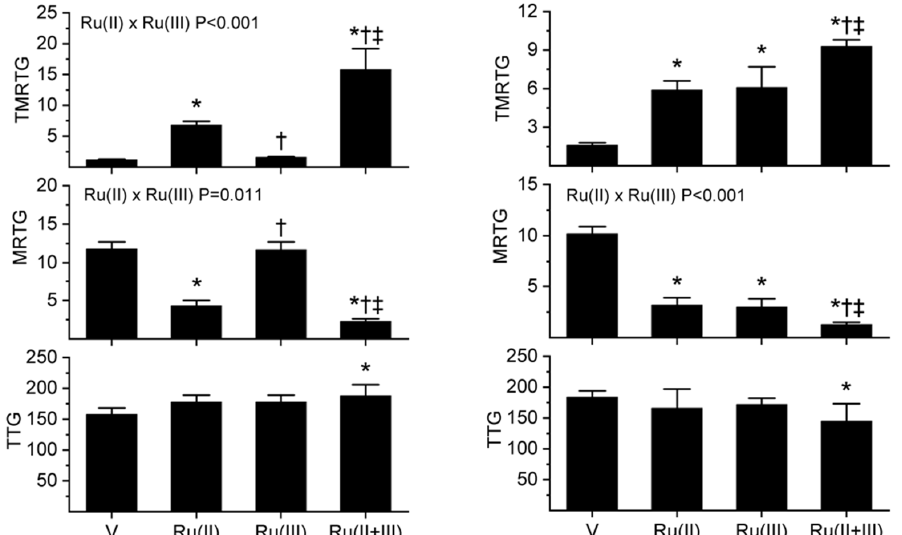
Figure 2. Procoagulant activity of B. moojeni venom (left panels) and C. rhodostoma venom (right panels) in plasma after exposure to CORM-2 (Ru(II)), RuCl 3 (Ru(III)) or both (Ru(II + III)) in isolation. Data is presented as mean ± SD. V = venom; Ru(II) = V + CORM-2 in PBS; Ru(III) = V + RuCl 3 ; Ru(II + III) = V + CORM-2 and RuCl 3 . * p < 0.05 vs. V; † p < 0.05 vs. Ru(II); ‡ p < 0.05 vs. Ru(III) via one-way analysis of variance (ANOVA) with Holm–Sidak post hoc test. Significant interactions between CORM-2 and RuCl 3 (Ru(II) × Ru(III)) determined with two-way ANOVA are displayed within individual parameter graphics.